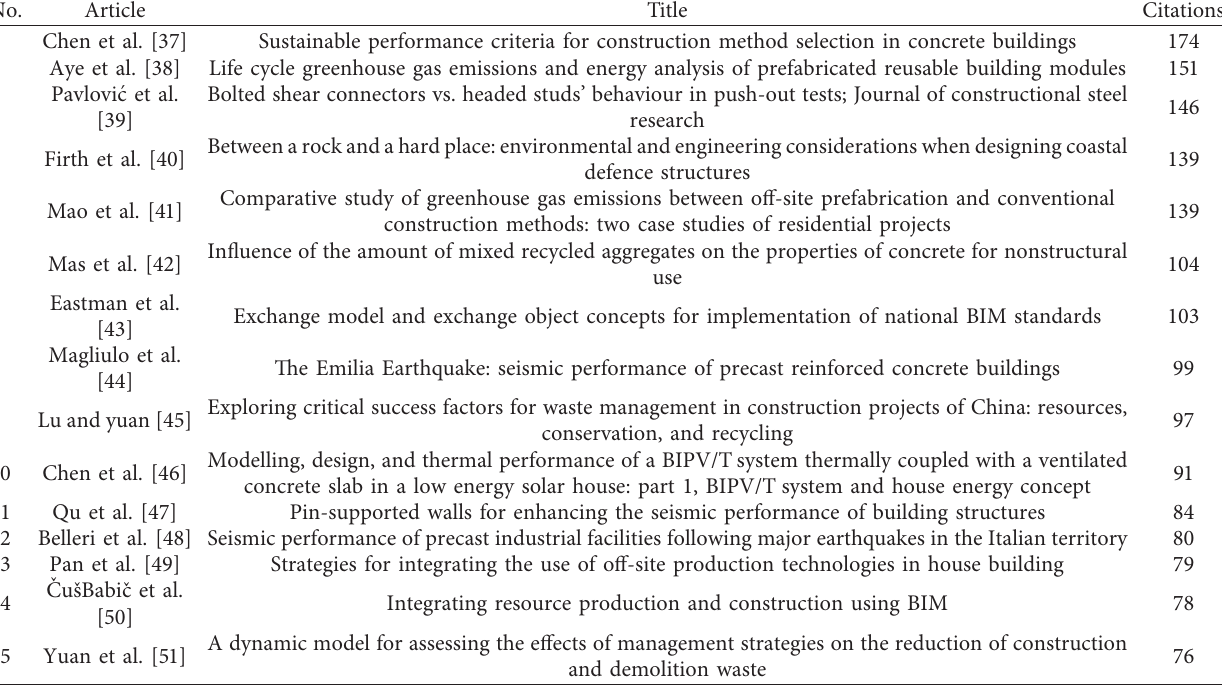
Table 9: Top 15 most cited documents.